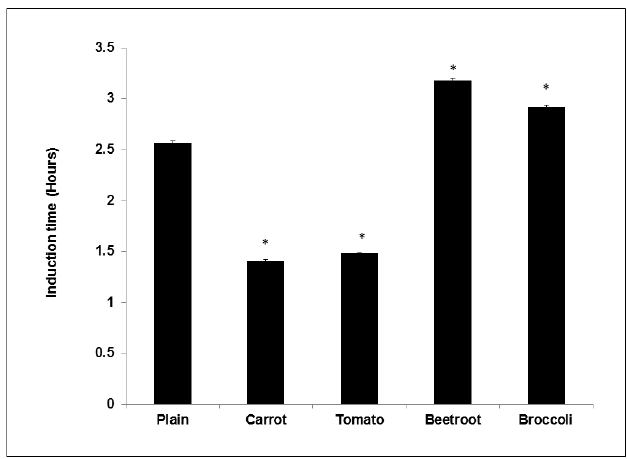
Figure 2. Oxidative stability of the breads measured using the Rancimat. Treatments with asterisks are significantly different to the plain bread ( p < 0.05). Values are means ± SE ( n = 4).